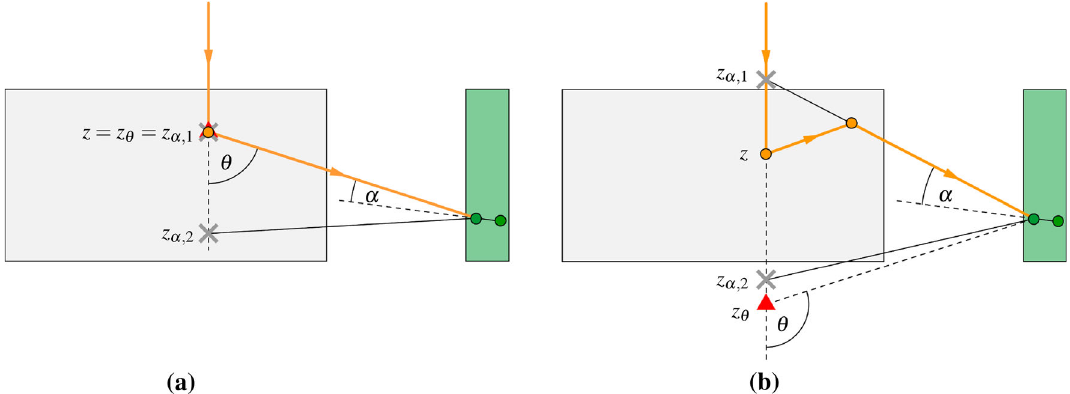
Fig. 11 Schematic of the trajectory of a fully-contained gamma for a a single-site event and b a multi-site event in the germanium detec- tor. Interaction points in the germanium detector and in the camera are shown asdots, thereconstructedinteractionpoint usingEq.(2)isshown